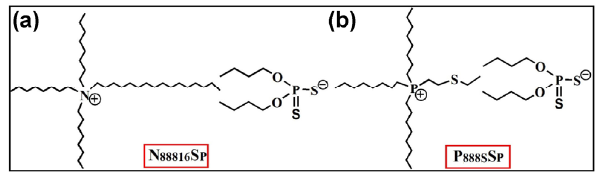
Fig. 1 Experimental